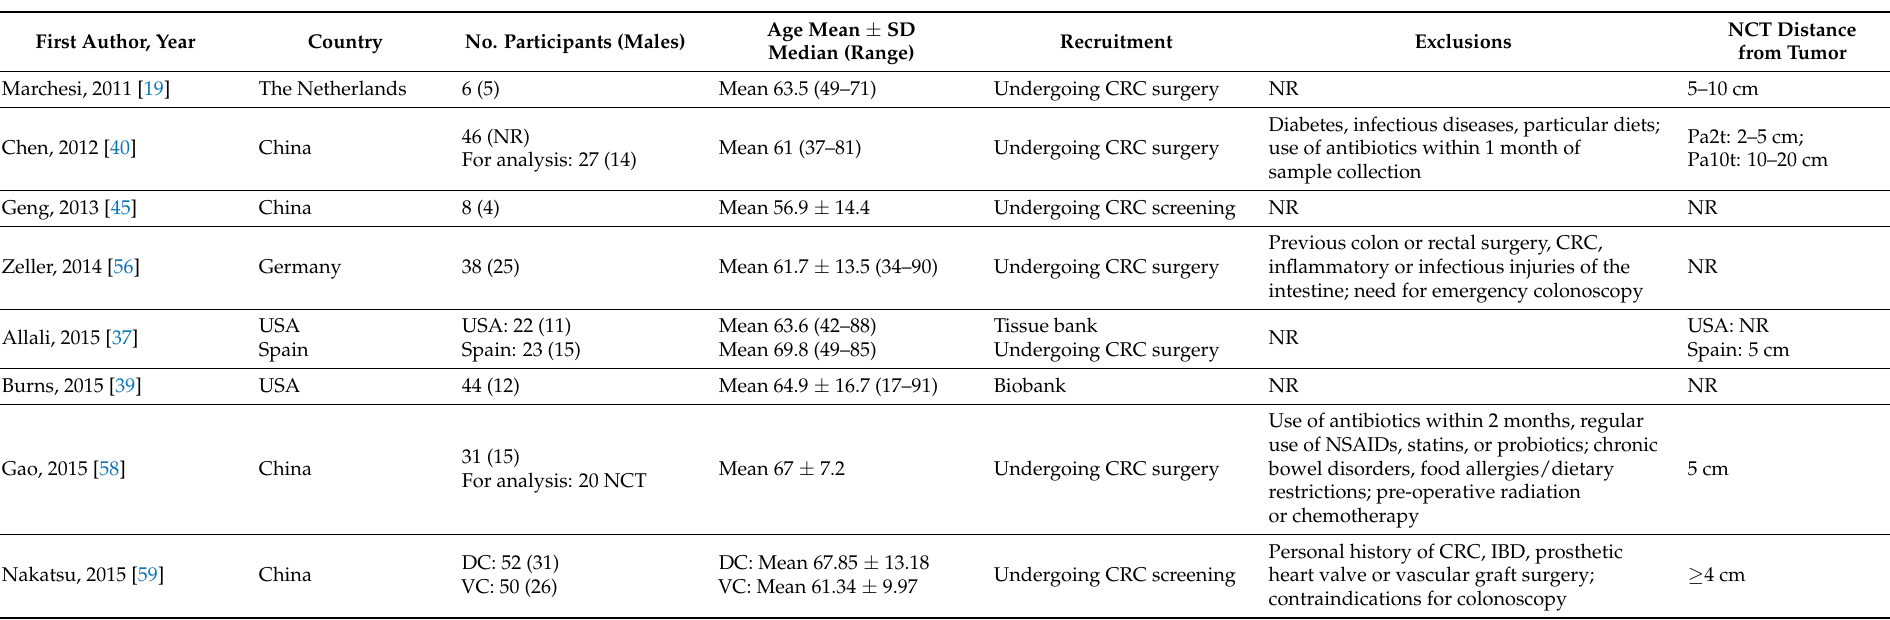
Table 2. Baseline characteristics of studies determining the microbiota of CRC and non-cancerous mucosal